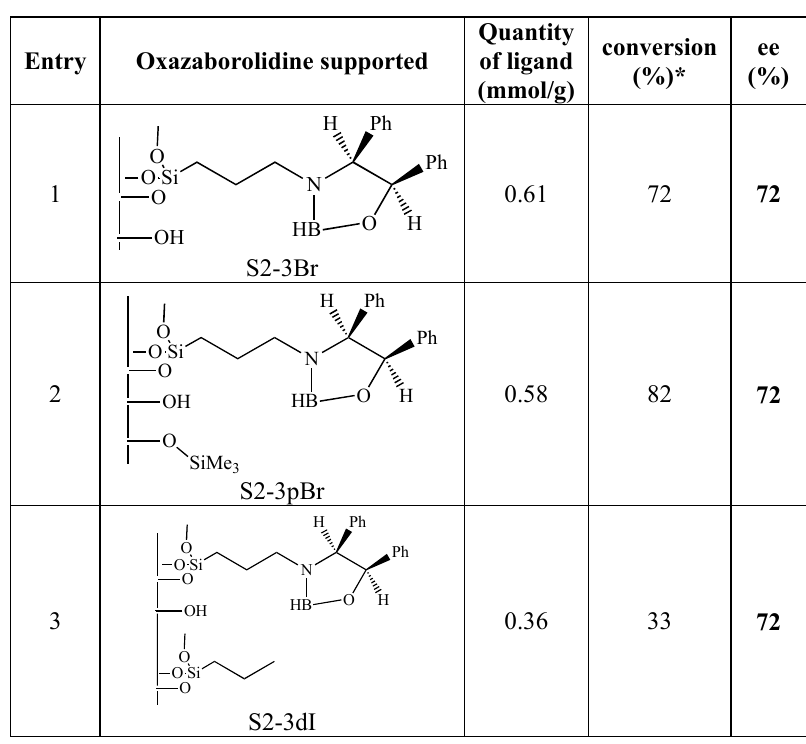
Table 7. Quantification of surface species and catalytic results for the supported oxazaborolidine at 28